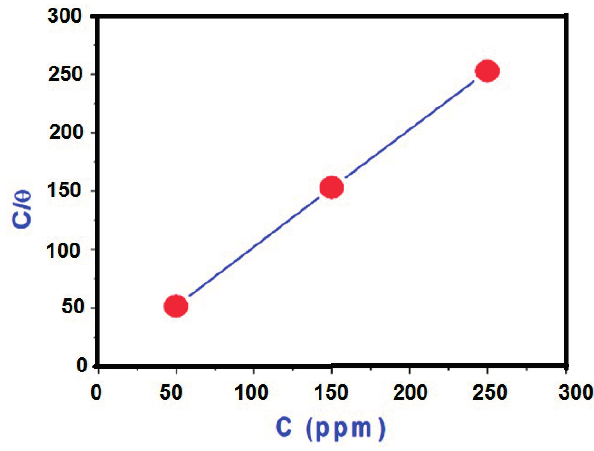
Figure 9. Langmuir adsorption plot of steel in 1 M HCl solution containing different concentrations of